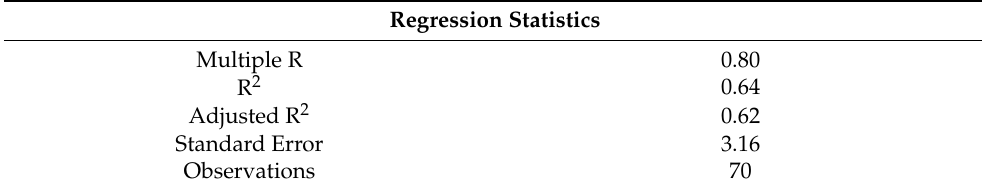
Table 1. Regression statistics for input variable to predict